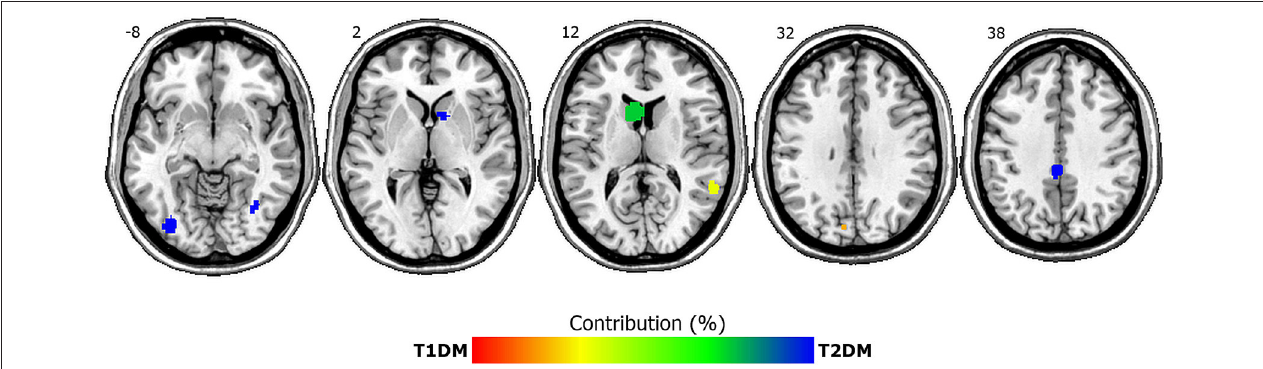
FIGURE 2 | ALE clusters of lower gray matter volumes in T1DM and T2DM compared to controls. Depicted are seven significant clusters, overlaid onto axial structural MRI planes Numbers depict z-coordinates in MNI space. Blue clusters are driven by T2DM whereas both disorders contribute to green-yellow clusters. Percent contribution is signaled by the color bar, with red indicating 100% contribution by T1DM and blue indicating 100% contribution by T2DM. Left is